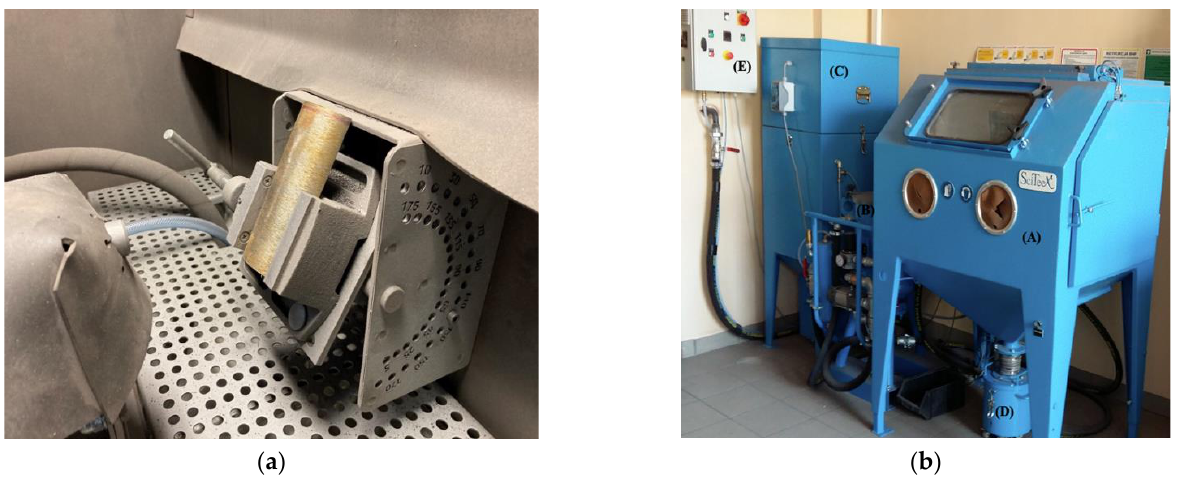
Figure 2. ( a ) The interior of the working chamber with the sample (16Mo3 steel reference material) mounted; ( b ) general view of the stand for testing the abrasive blasting resistance of materials.